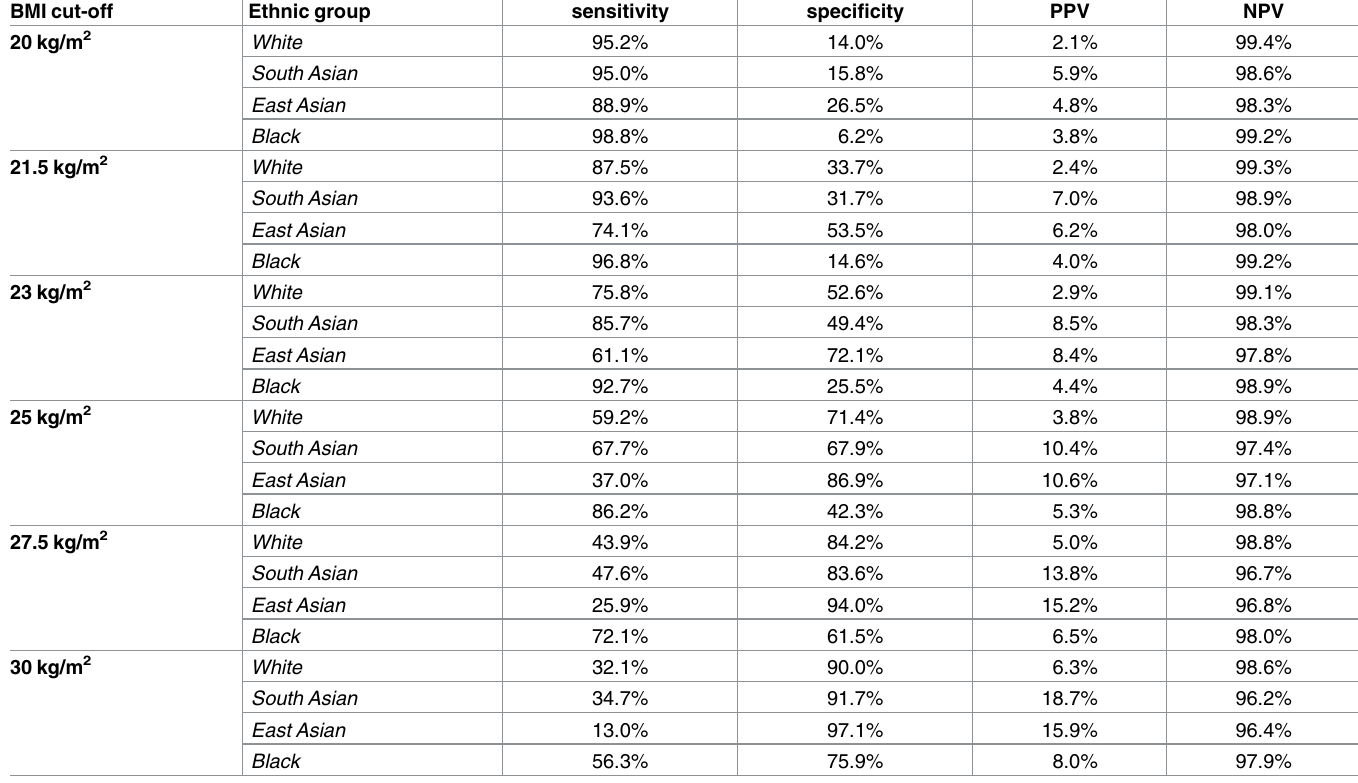
Table 3. Sensitivity, specific, PPV and NPV for specified BMI cut-offs, by ethnic group. BMI